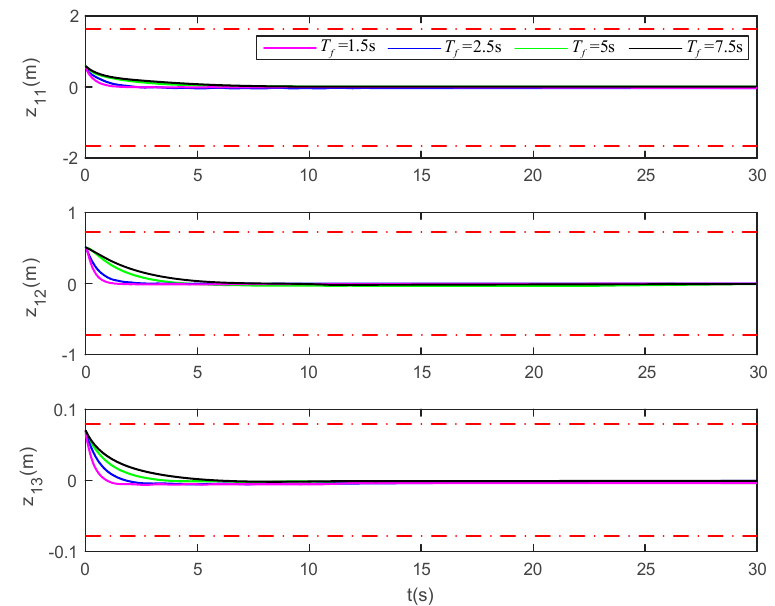
Figure 21. Pose tracking error of the vessel under different settling time. (The upper and lower red dotted lines are error constraint boundaries).